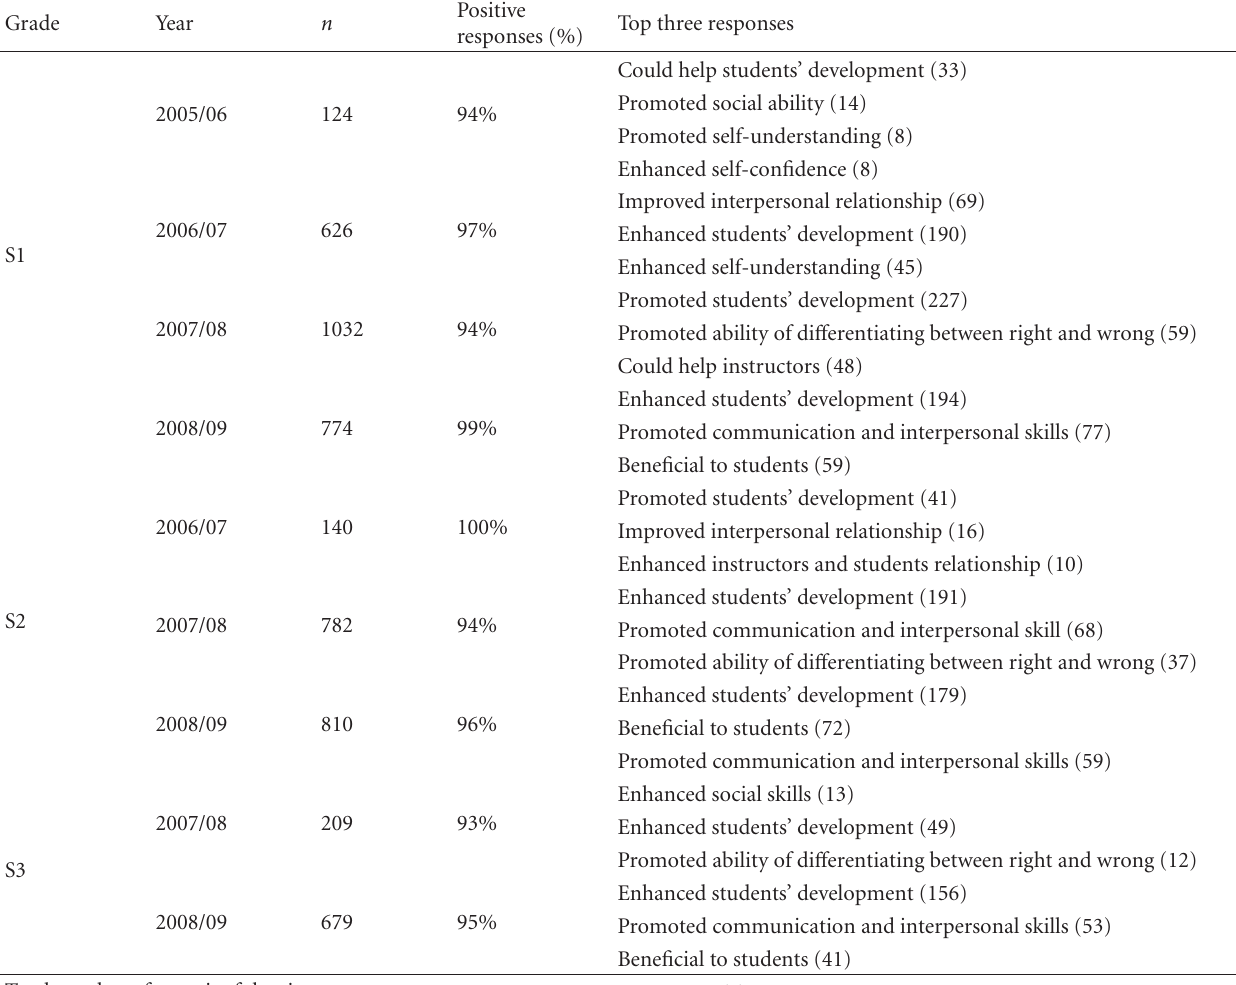
Table 4: Perceived e ff ectiveness of the Tier 1 Program in di ff erent